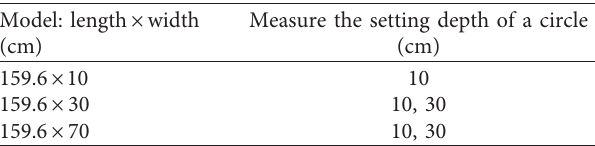
Table 3: Dimension table of numerical calculation